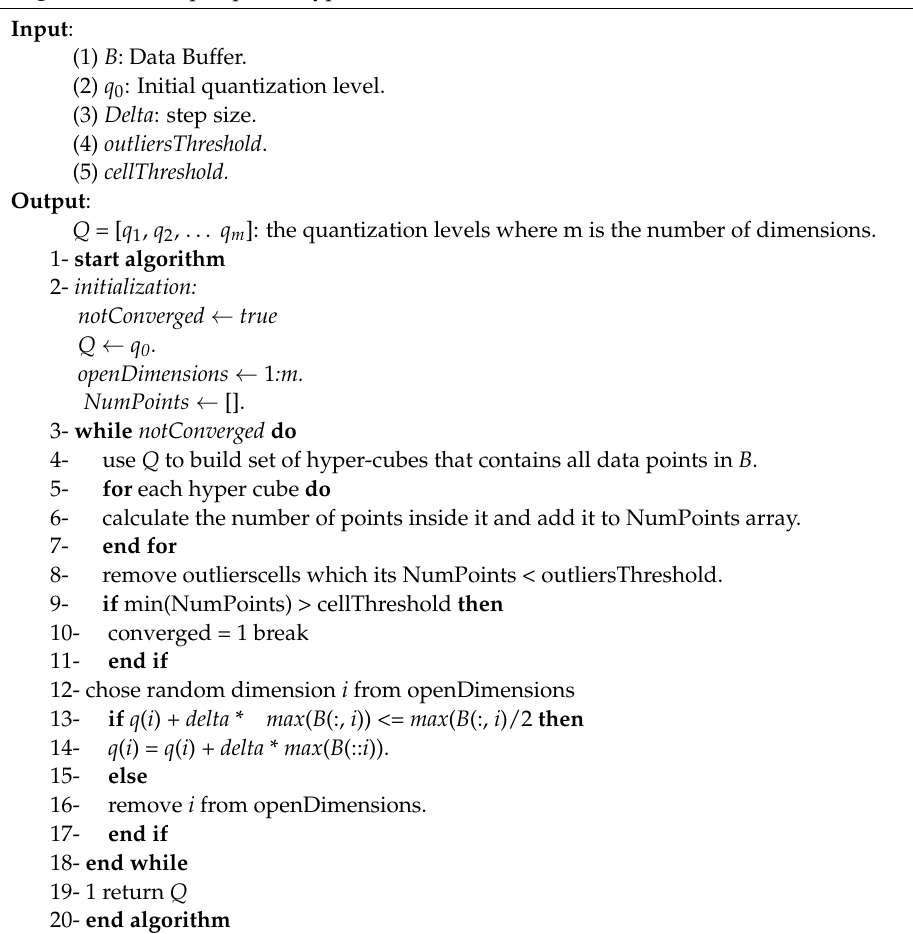
Algorithm 1: Tempo Spatial Hyper